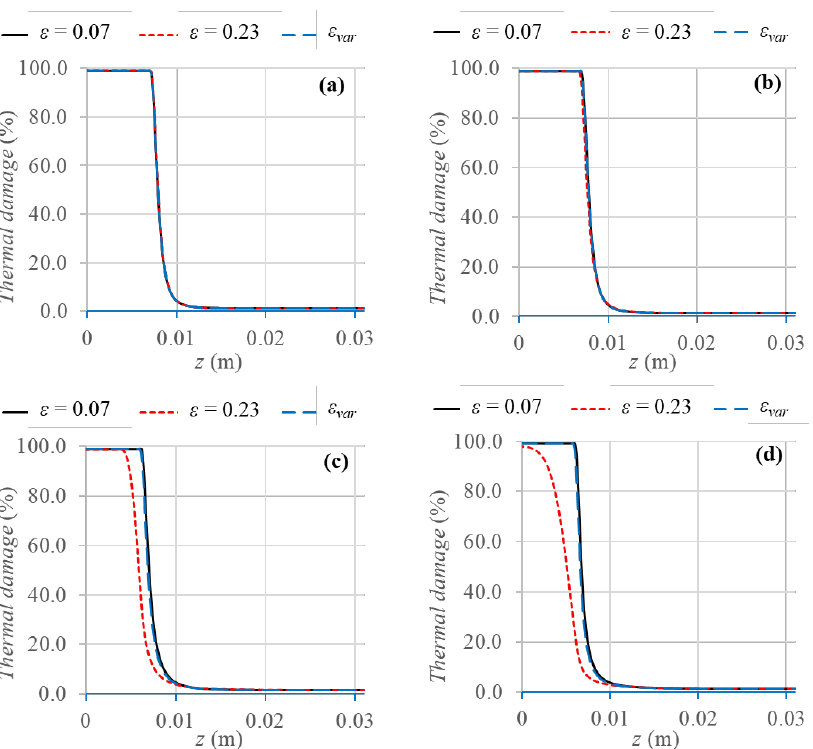
Figure 5. Axisymmetric view of thermal damage percentage evaluated after 100 s of thermal treat- ment for the three different porosity models and the four different blood vessels: ( a ) capillaries, ( b ) terminal arteries, ( c ) terminal branches, and ( d ) tertiary branches. Table 5. Coagulation diameters obtained for the different porosity